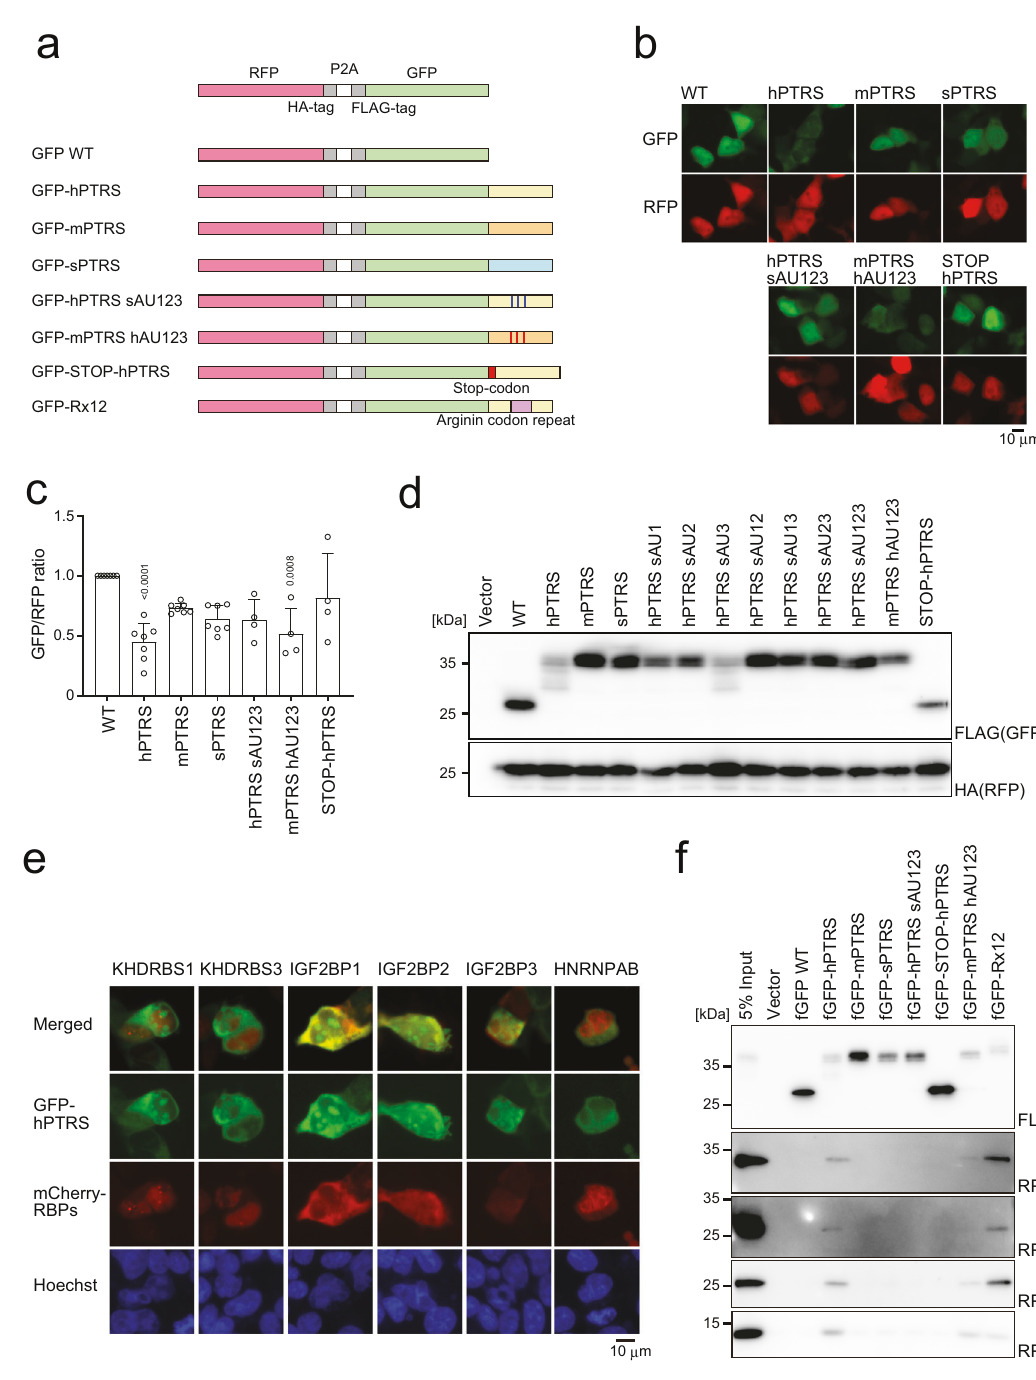
Fig.6|RBPcomplexinhibitstranslationofMLL-AF4.a Schematicrepresentation of the reporter constructs for post-transcriptional regulation. b Subcellular locali- zation of GFP and RFP reportersin293T cells. c Relative fl uorescent signals of GFP andRFPreporters.The fl uorescentintensitieswereanalyzedusingImageJsoftware and expressed asthe GFP/RFPratio( n =7:WT,hPTRS,mPTRS,sPTRS; n =4:hPTRS sAU123, mPTRS hAU123, STOP-hPTRS). Data are presented as the mean±SD of indicated biologically independent replicates. P -value was calculated by one-way ANOVA followed by Tukey ’ s test. d Western blotting of the GFP/RFP reporter proteins in 293T cells transiently expressing the constructs. GFP and RFP proteins